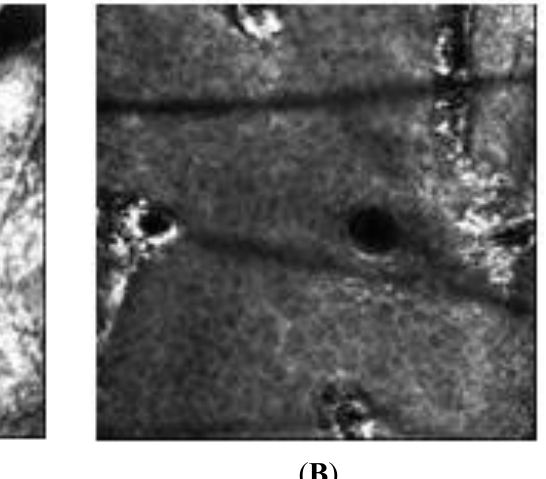
Figure 6. Images obtained by confocal laser microscopy of the different skin